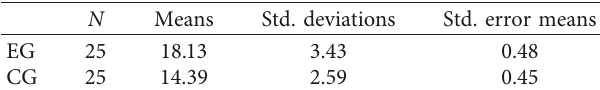
Table 8: DS of motivation